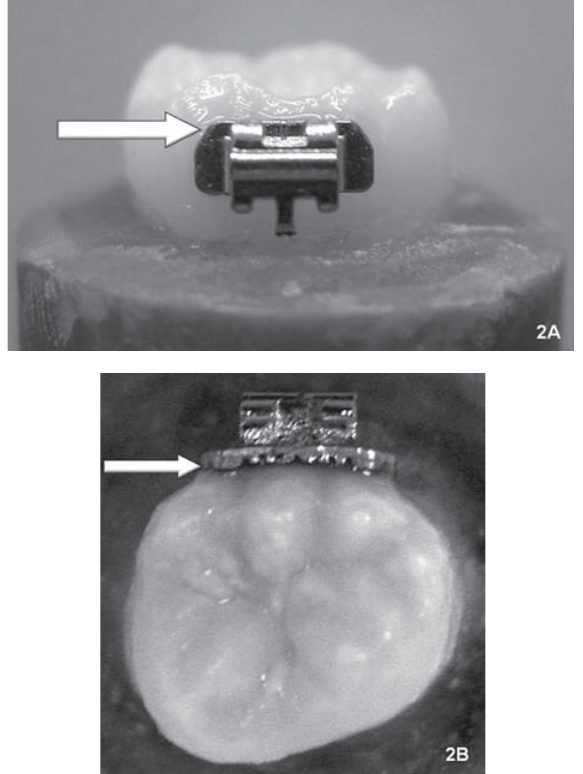
Figure 2- Specimen preparation. Group 2 and Group 3: conventional direct bond (A: vestibular view; B: occlusal view) Table 1- Bond strength data [means, standart deviation (SD), median, minimum and maximum values], in MPa and in kilograms (Kg)